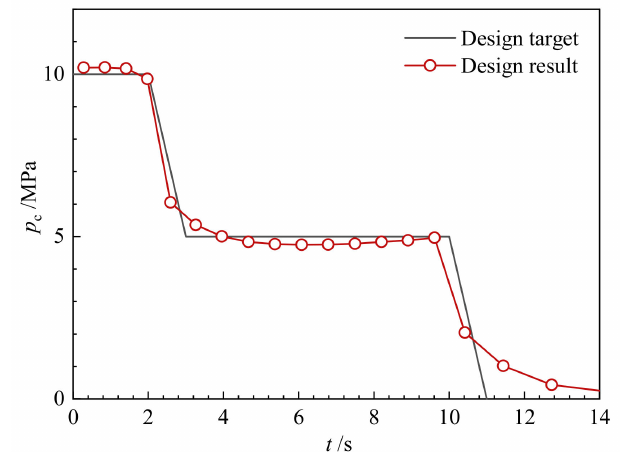
Figure 28. Relation between the dimensionless burn perimeter and dimensionless web thickness of the designed grain.